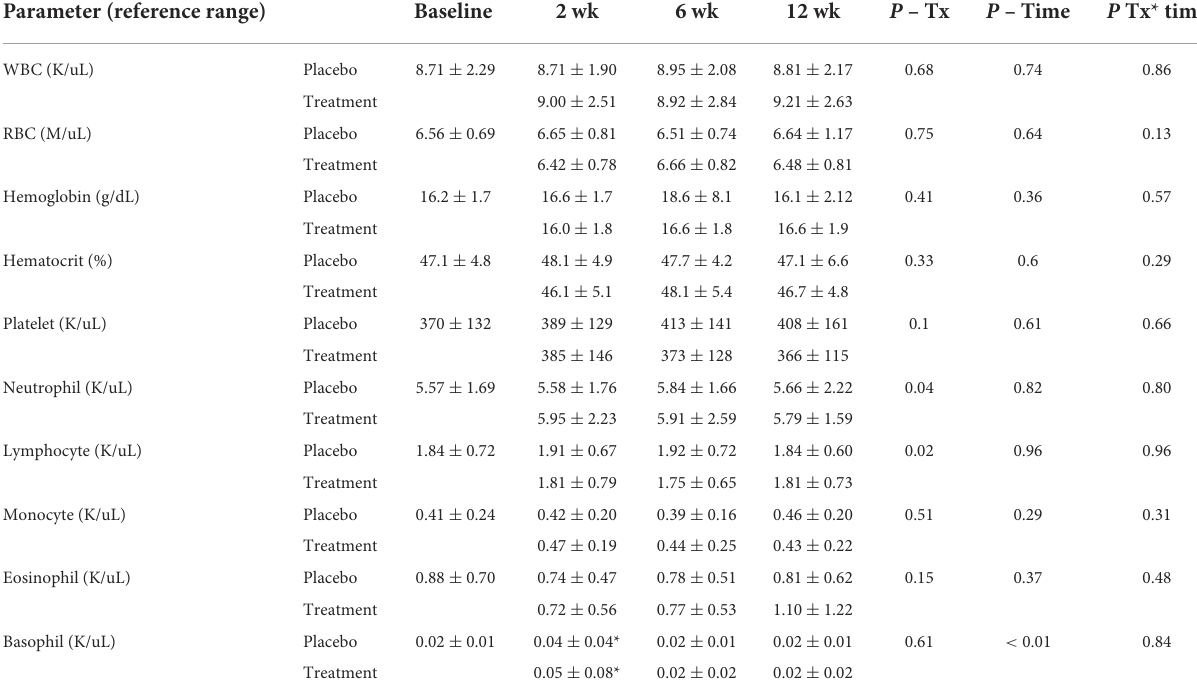
TABLE 1 Complete blood count means and standard deviations at baseline, 2, 6, and 12 weeks of CBD/CBDA-rich hemp oil vs. placebo ( n = 14) in a randomized cross over clinical